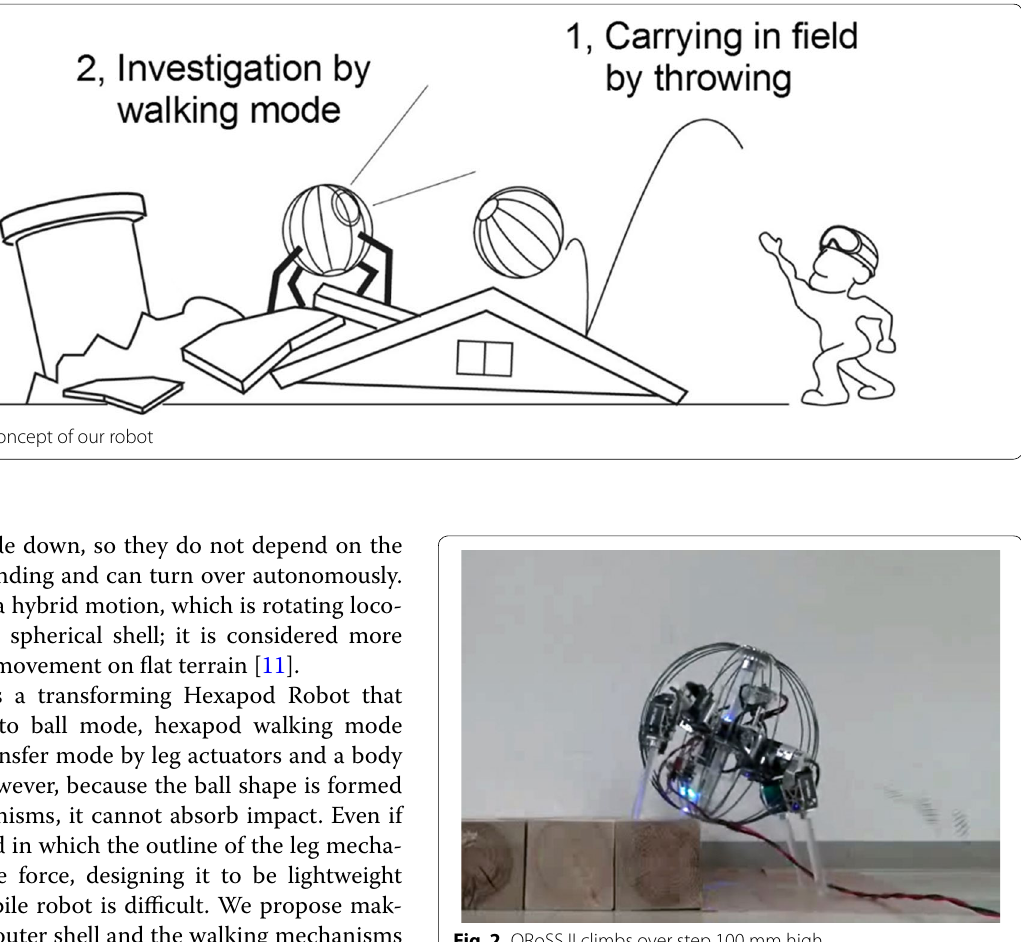
Fig. 2 QRoSS II climbs over step 100 mm